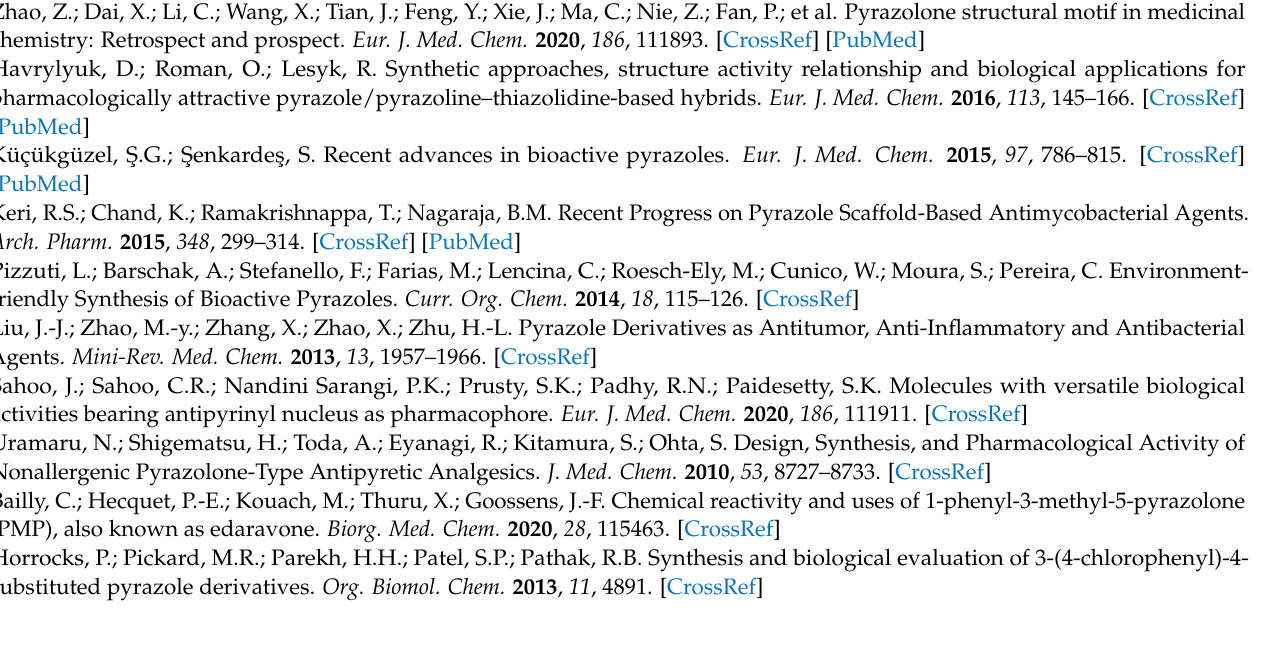
NMR spectrum of compound 6i ; Figure S79. 1 H NMR spectrum of compound 7a ; Figure S80. 13 C NMR spectrum of compound 7a ; Figure S81. 19 F NMR spectrum of compound 7a ; Figure S82. 1 H NMR spectrum of compound 7b ; Figure S83. 13 C NMR spectrum of compound 7b ; Figure S84. 19 F NMR spectrum of compound 7b ; Figure S85. 1 H NMR spectrum of compound 8a ; Figure S86. 13 C NMR spectrum of compound 8a ; Figure S87. 19 F NMR spectrum of compound 8a ; Figure S88. 1 H NMR spectrum of compound 8b ; Figure S89. 13 C NMR spectrum of compound 8b ; Figure S90. 19 F NMR spectrum of compound 8b ; Figure S91. 1 H NMR spectrum of compound 9a ; Figure S92. 13 C NMR spectrum of compound 9a ; Figure S93. 1 H NMR spectrum of compound 9b ; Figure S94. 13 C NMR spectrum of compound